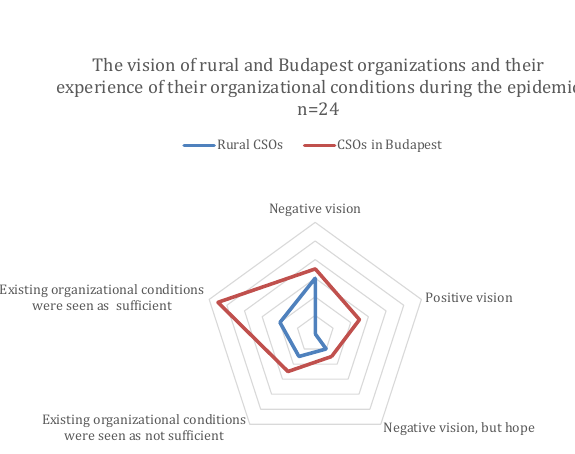
Figure 6: The rural and Budapest CSOs ’ idea about their future perspectives, and their experience of their own organizational conditions during the